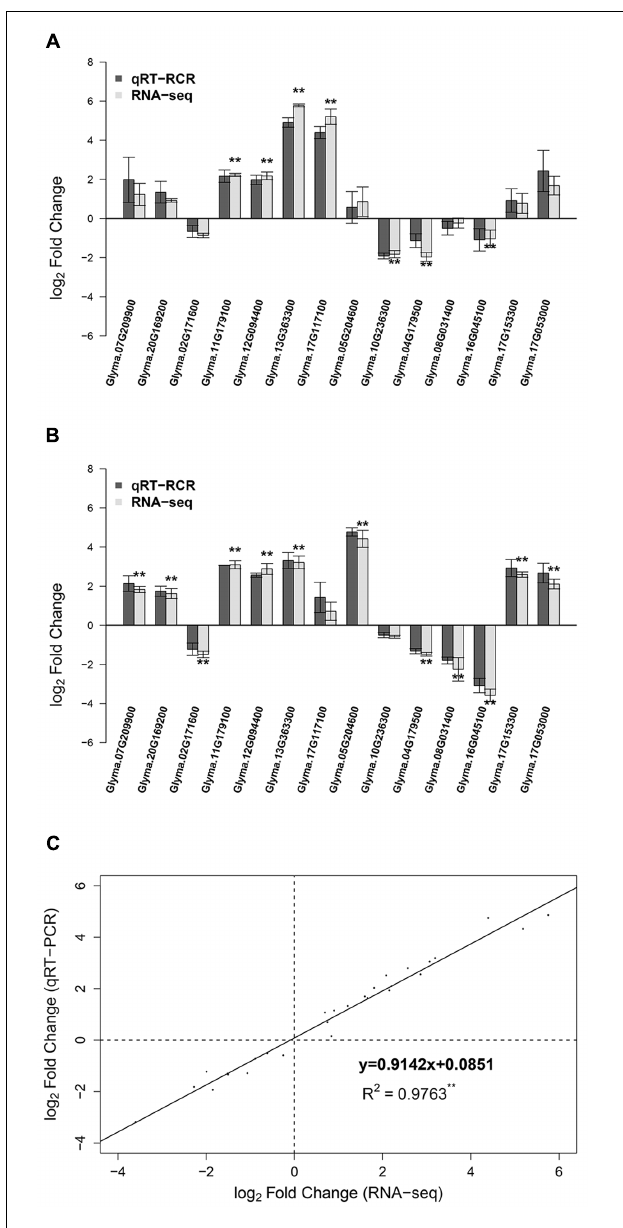
FIGURE 5 | Comparison of RNA-seq results and qRT-PCR analysis of gene expression levels. (A) Log 2 fold change of 14 genes at 12 h after 90 mM NaHCO 3 (pH = 8.5) stress. (B) Log 2 fold change of 14 genes at 24 h after 90 mM NaHCO 3 (pH = 8.5) stress. (C) The comparison of log 2 fold change obtained by RNA-seq ( x -axis) and qRT-PCR ( y -axis). ∗∗ Differentially expressed genes at FDR ≤ 0.01 and | log 2 FoldChange| ≥ 1 from